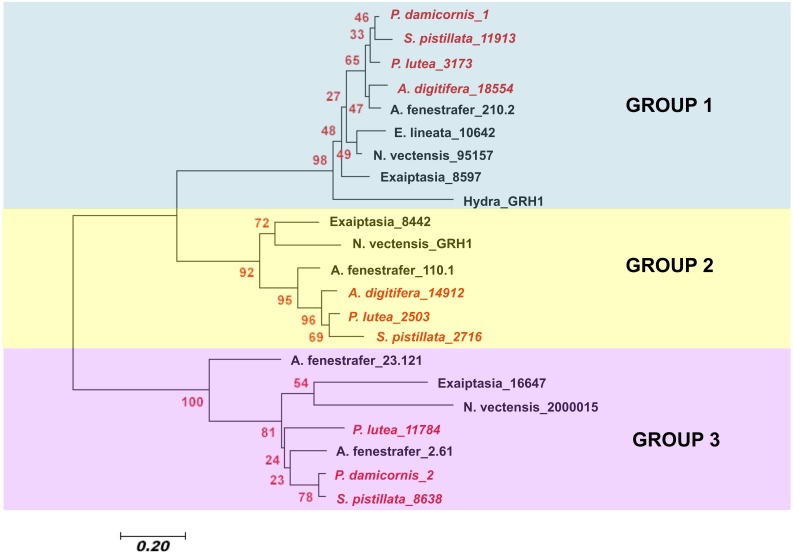
Neighbor-Joining tree of the evolutionary relatedness of Grainyhead proteins in cnidarians.The evolutionary history was inferred using the Neighbor-Joining method ( Saitou & Nei, 1987). The optimal tree with the sum of branch length = 5.13670293 is shown. The percentage of replicate trees in which the associated taxa clustered together in the bootstrap test (2,000 replicates) is shown next to the branches (Felsenstein, 1985). The tree is drawn to scale, with branch lengths in the same units as those of the evolutionary distances used to infer the phylogenetic tree. The evolutionary distances were computed using the Poisson correction method (Zuckerkandl & Pauling, 1965) and are in the units of the number of amino acid substitutions per site. The analysis involved 22 amino acid sequences. All positions with less than 95% site coverage were eliminated. That is, fewer than 5% alignment gaps, missing data, and ambiguous bases were allowed at any position. There were a total of 44 positions in the final dataset. Evolutionary analyses were conducted in MEGA7 (Kumar, Stecher & Tamura, 2016). Scleractinia is in red italic writing, while all other cnidarians are in black bold face. Sequences used in this study are found in Table S2.